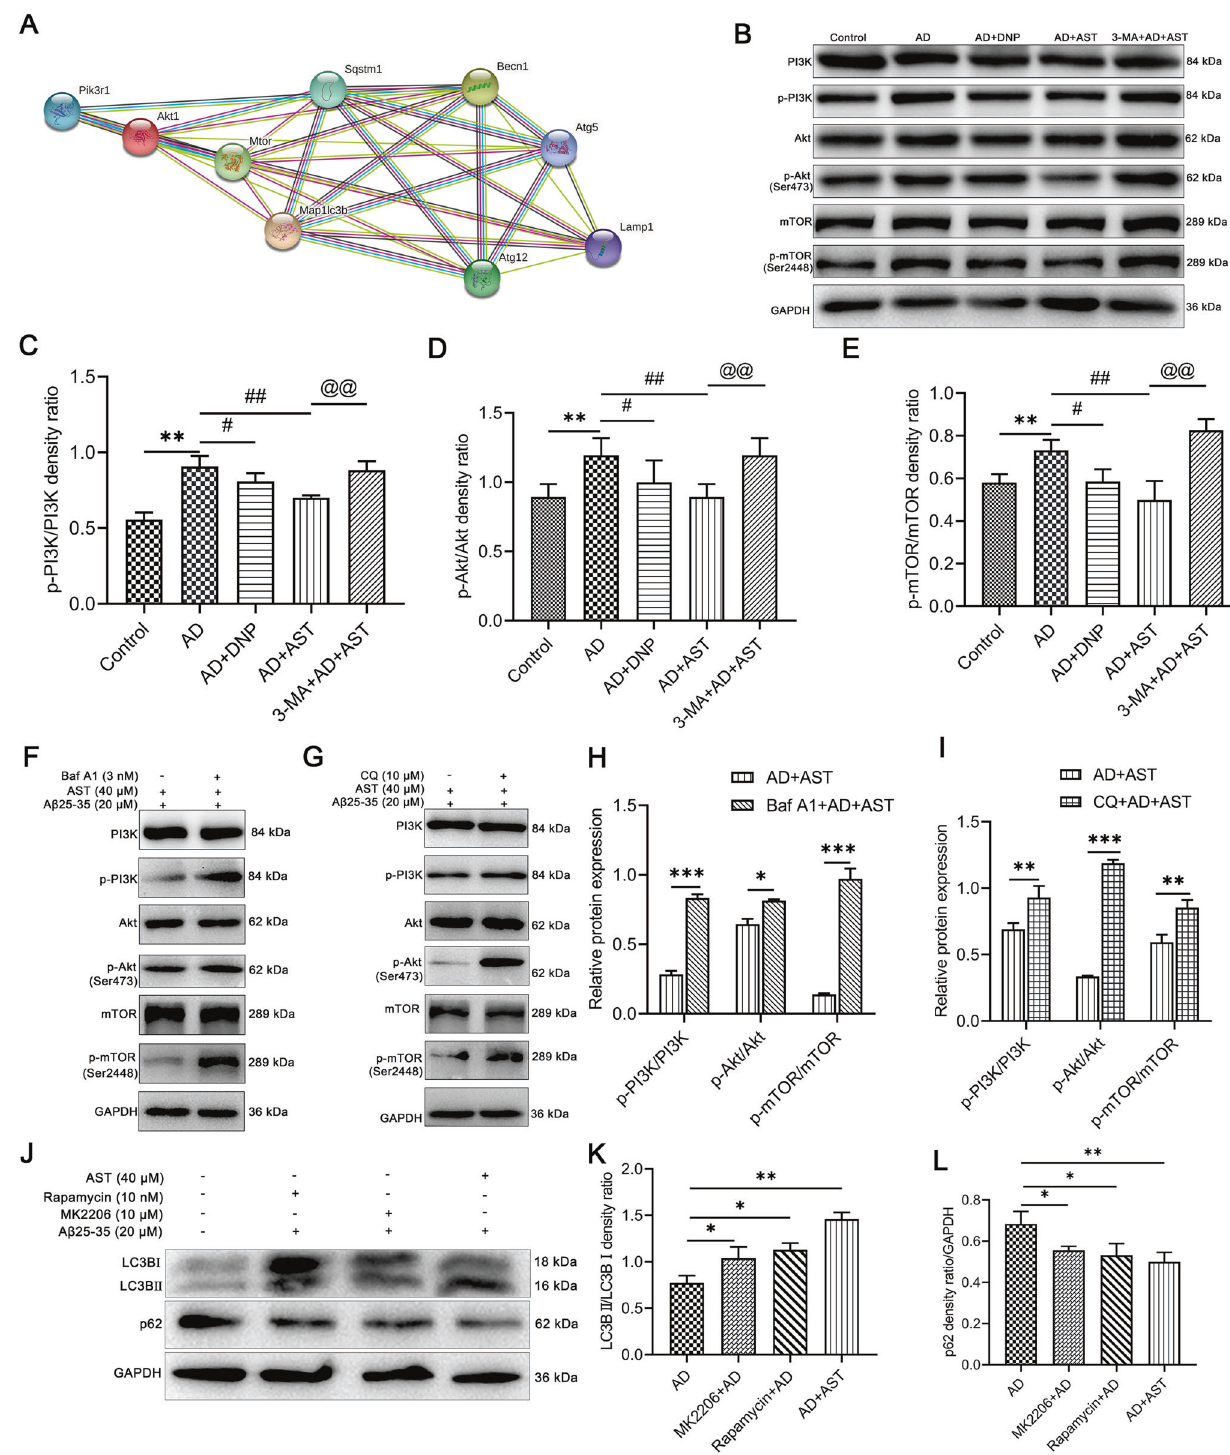
Fig. 8 AST pretreatment decreased the phosphorylation levels of PI3K, Akt, and mTOR in the AD cells group. A Protein-protein interaction analysis of differently expressed autophagy-associated proteins using STRING database. B Representative bands of PI3K, p-PI3K, Akt, p-Akt, mTOR, and p-mTOR by WB detection in the HT22 cells. C – E Statistical analysis of p-PI3K/PI3K, p-Akt/Akt, and p-mTOR/mTOR in HT22 cells. Data were presented as mean ± SD, n = 3/group. ** p < 0.01 vs control group, # p < 0.05 and ## p < 0.01 vs AD group, @@ p < 0.01 vs AST + AD group. F , G The expression levels of PI3K, p-PI3K, Akt, p-Akt, mTOR, and p-mTOR were detected by WB after the addition of Baf A1 or CQ in AD cell model. H , I Statistical analysis of p-PI3K/PI3K, p-Akt/Akt, and p-mTOR/mTOR in HT22 cells of each group. Data were presented as mean ± SD, n = 3/group. * p < 0.05, *** p < 0.01 and *** p < 0.001 vs AST + AD group. J The expression levels of LC3BII/LC3BI and p62 were detected by WB after the addition of MK2206 or rapamycin in A β 25-35-injured HT22 cells. K , L Statistical analysis of the corresponding LC3BII/LC3BI and p62 protein bands. Data were presented as mean ± SD, n = 3/group. * p < 0.05, ** p < 0.01 vs AD group.